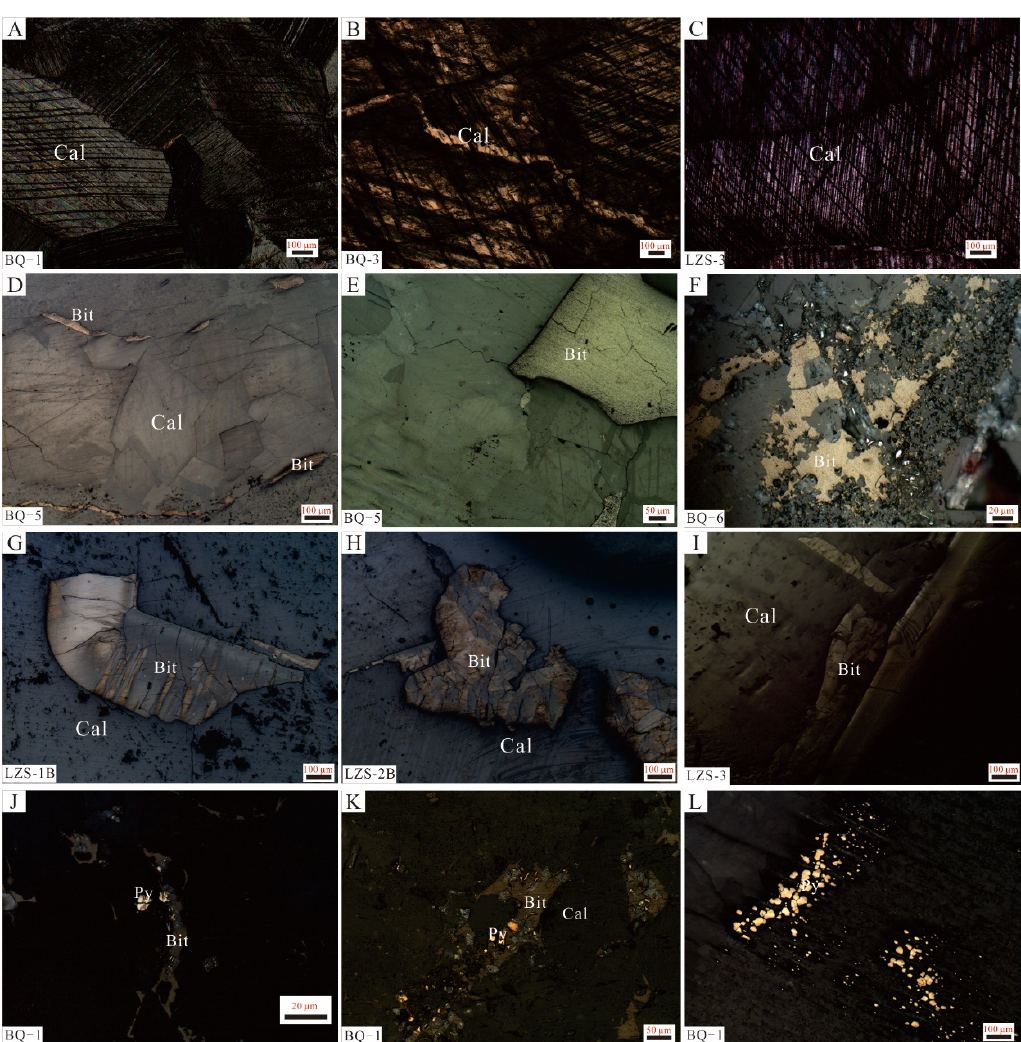
Figure 4. Photographs showing the characteristic of black/gray calcite of the Banqi-Yata-Laizishan area. ( A – C ) Fine-grained calcite with clear and continuous cleavage lines. ( D ) Bitumen banded along the edge of calcite veins. ( E , F ) Bitumen with the pore of the calcite in the Banqi area. ( G – I ) Solid bitumen within the calcite pores from the Laizishan area. ( J – L ) Reflected light image showing pyrite within the black calcite.